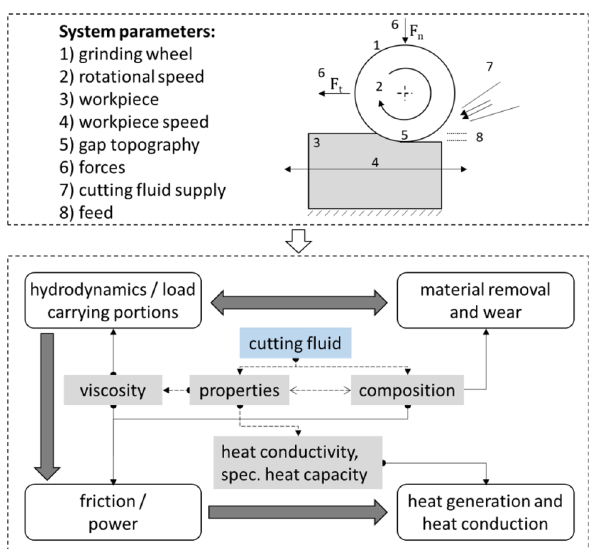
Fig. 1 Scheme of the interactions in the contact zone of grinding processes under presence of cutting